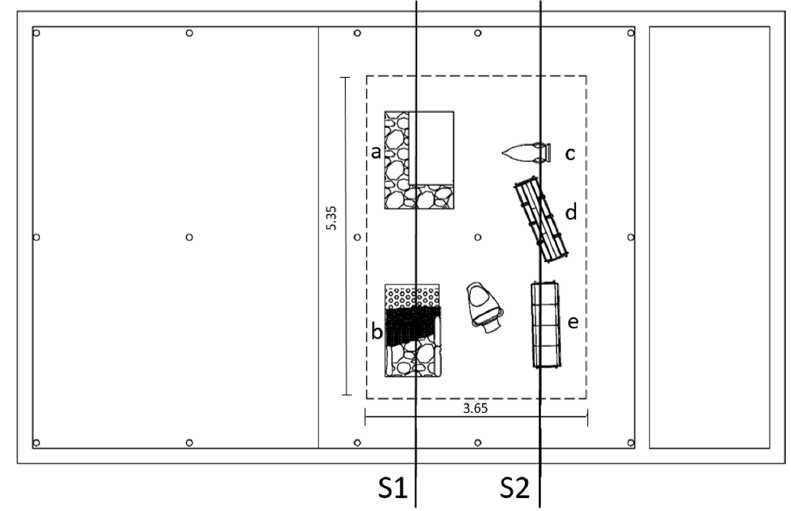
Figure 2. Plan of the investigated site with indication of the archaeological structures placed into wet sand: ( a ) wall; ( b ) paved road; ( c ) amphora; ( d ) capuchin tomb; ( e ) rectangular tomb.